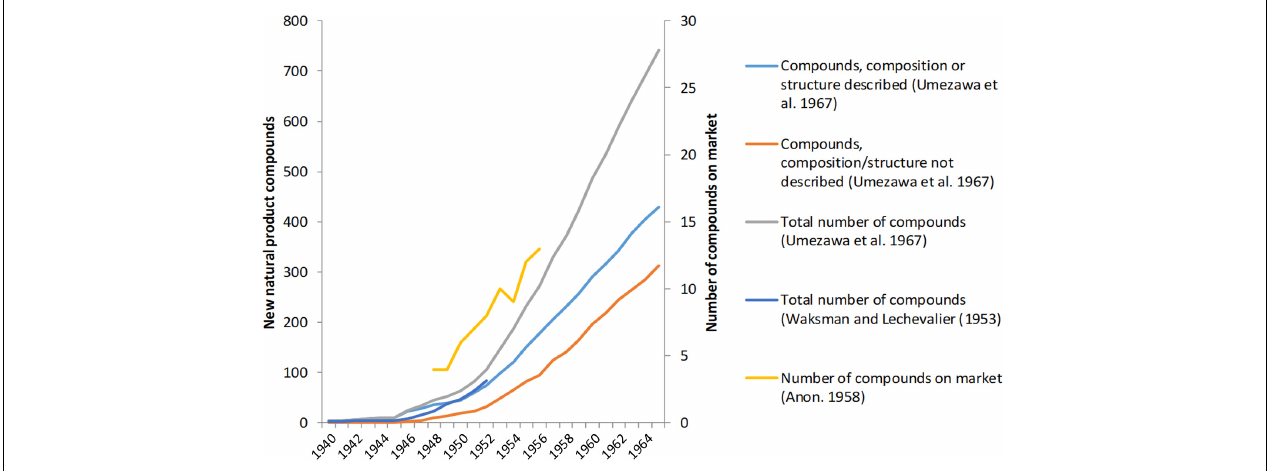
FIGURE 1 | Discoveries of new natural product antibiotics produced by actinomycetes 1940–1965 (data from Waksman and Lechevalier, 1953 and Umezawa et al., 1967) and numbers of actinomycetes antibiotics available on the American market during the late 1940s-early 1950s (data from Anon,